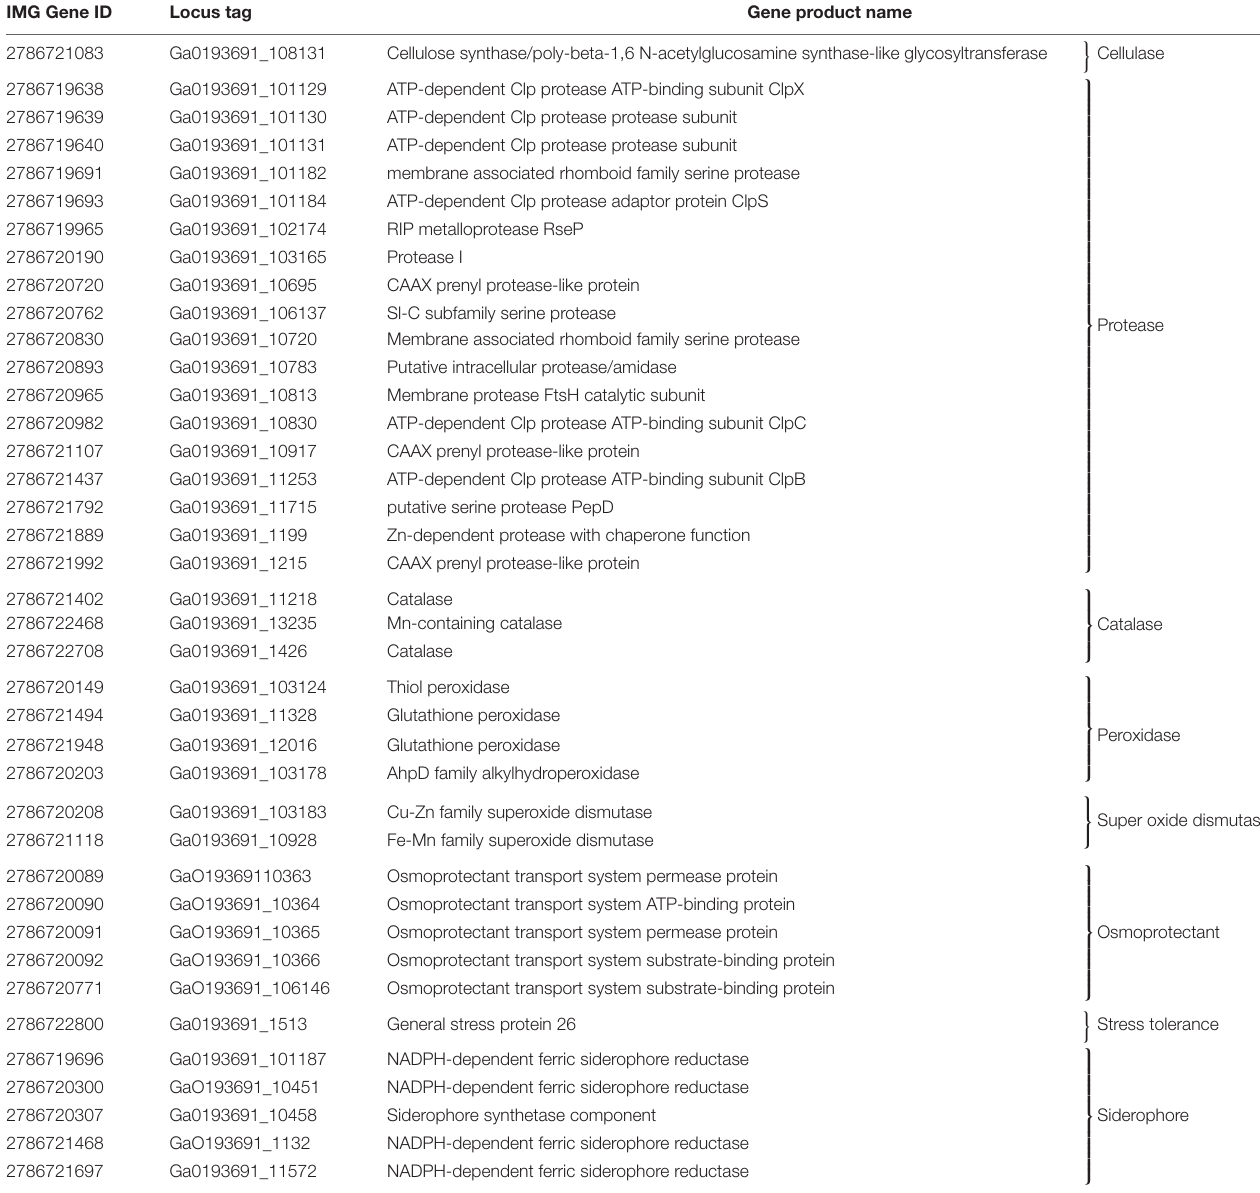
TABLE 4 | Plant beneficial function genes in D. cinnamea 55. IMG Gene ID Locus